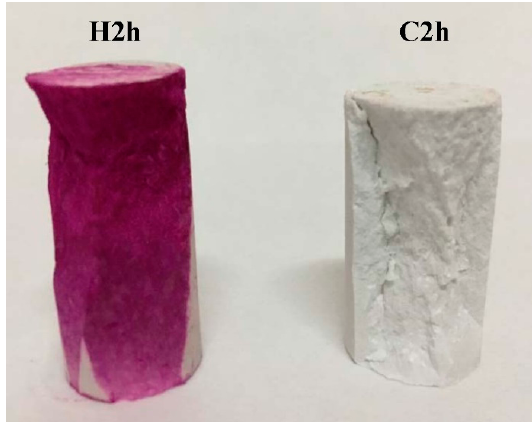
Figure 8. Samples sprayed by an alcohol phenolphthalein solution.